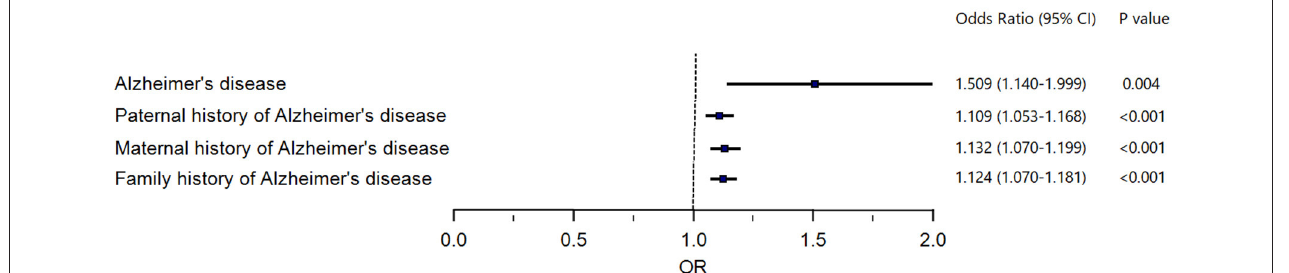
FIGURE 2 | Forest plot to visualize causal effect of LDL-C on the risk of Alzheimer’s disease. LDL-C, low-density lipoprotein